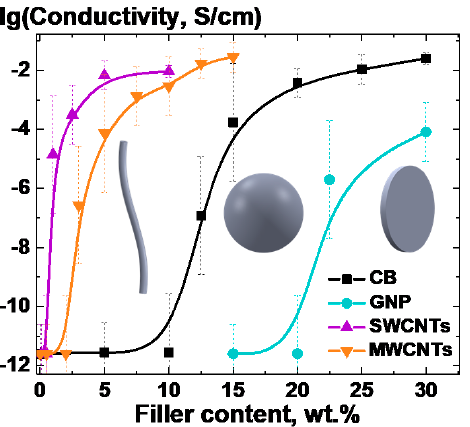
Figure 6. Dependences of the electrical conductivity of composites based on polypropylene (PP) on the content of various fillers (CB, GnPs, MWCNTs, SWCNTs) in the composite. Table 2. Percolation thresholds for PP composites filled with various fillers, determined from the experimental data and the